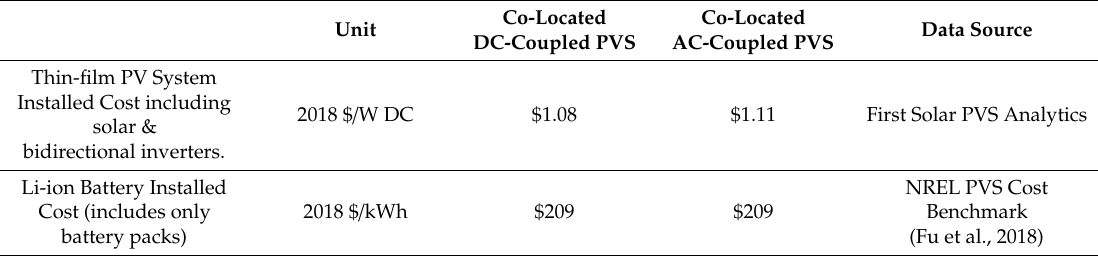
Table A5. Unitized cost assumptions for co-located DC and AC coupled PVS